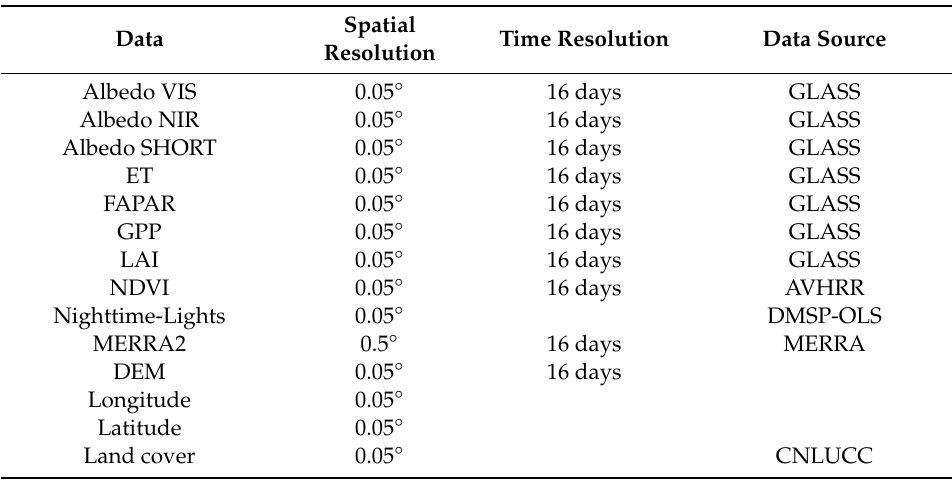
Table 2. Introduction to data used in this